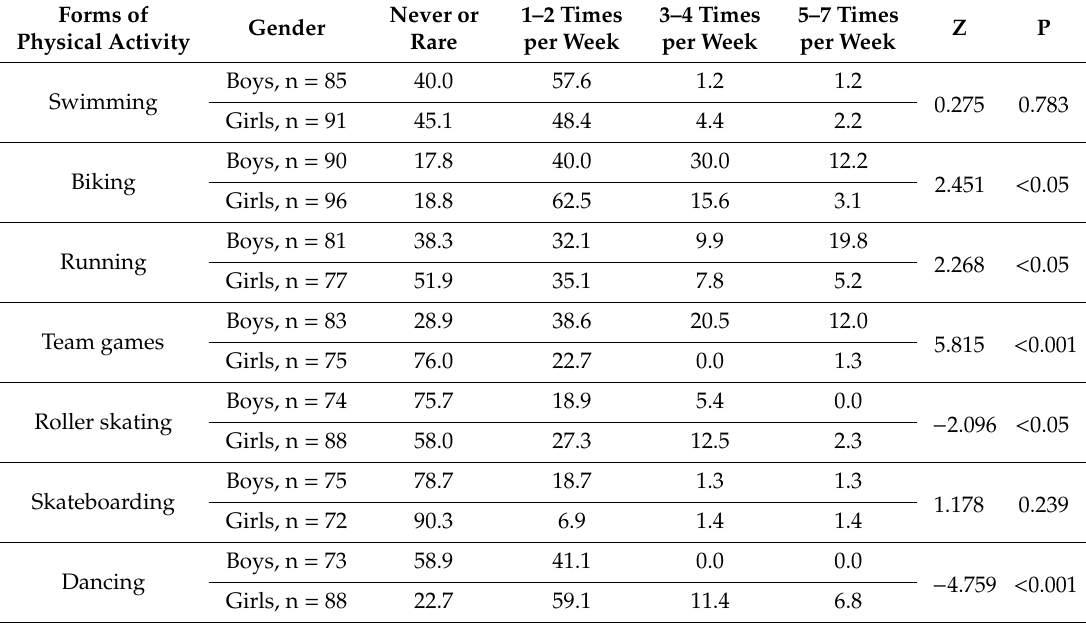
Table 1. Di ff erences between boys and girls in frequency of undertaking of di ff erent forms of PA. Forms